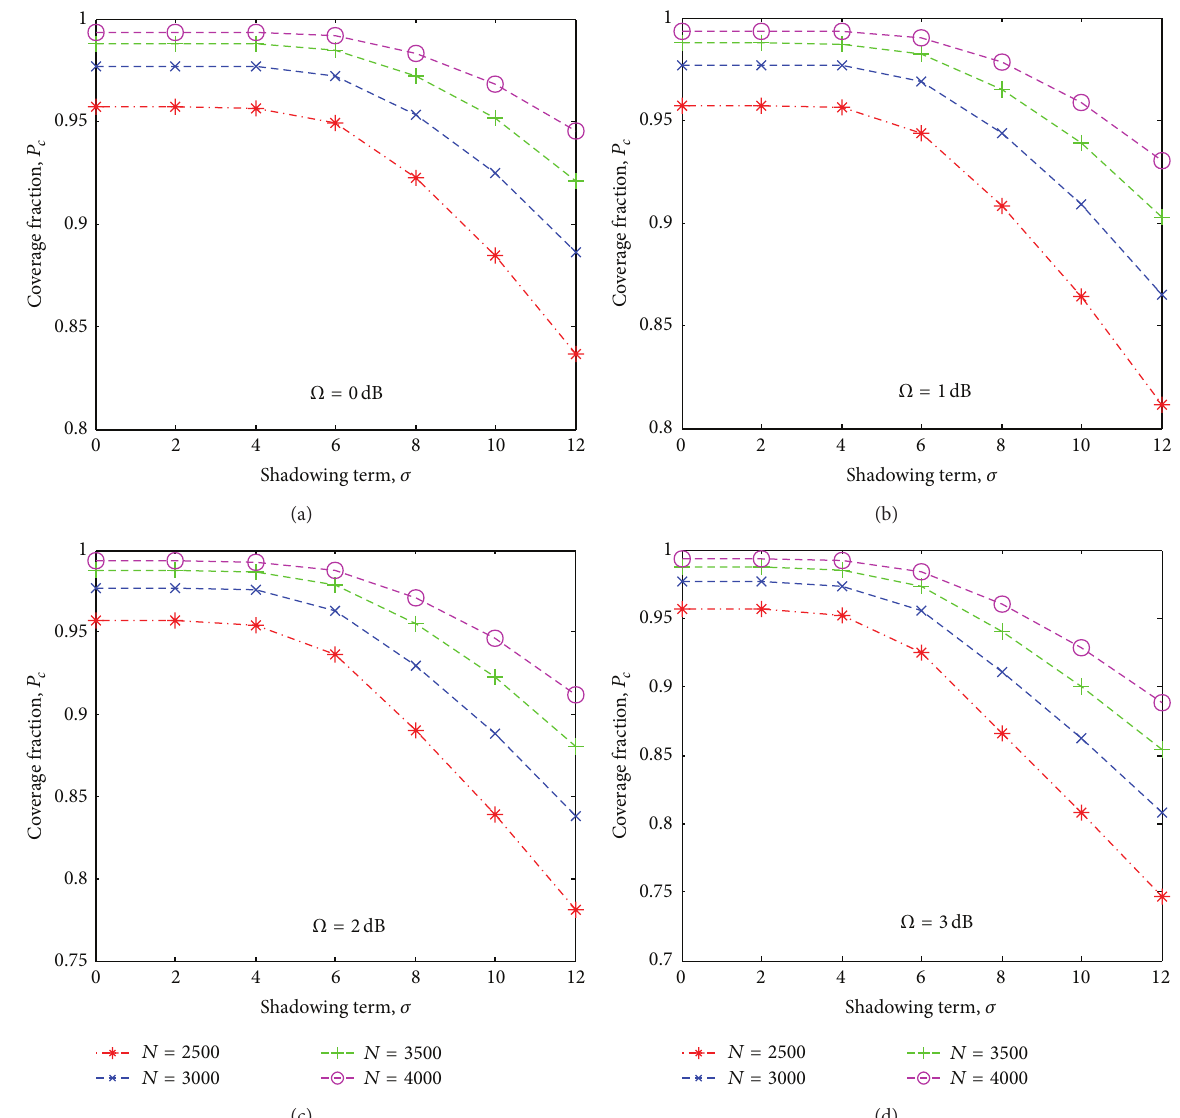
Figure 6: Coverage probability 𝑃 𝑐 versus shadowing 𝜎 term and multipath term Ω for different sensor nodes.